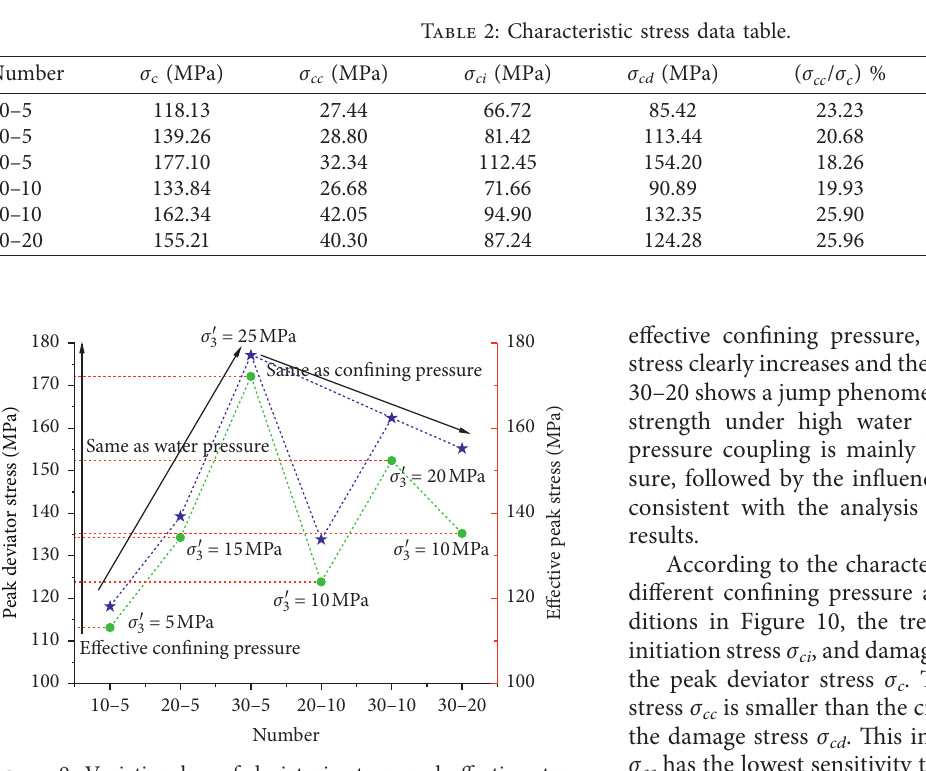
Figure 9: Variation law of deviatoric stress and effective stress under different confining pressure and pore water pressure